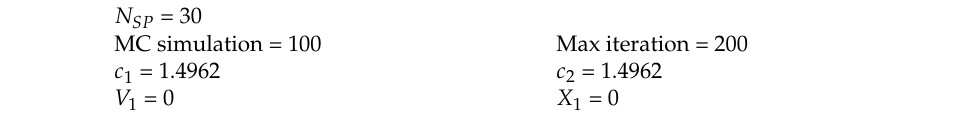
Table 1. Table of Parameters Used Throughout the Simulation. N SP =